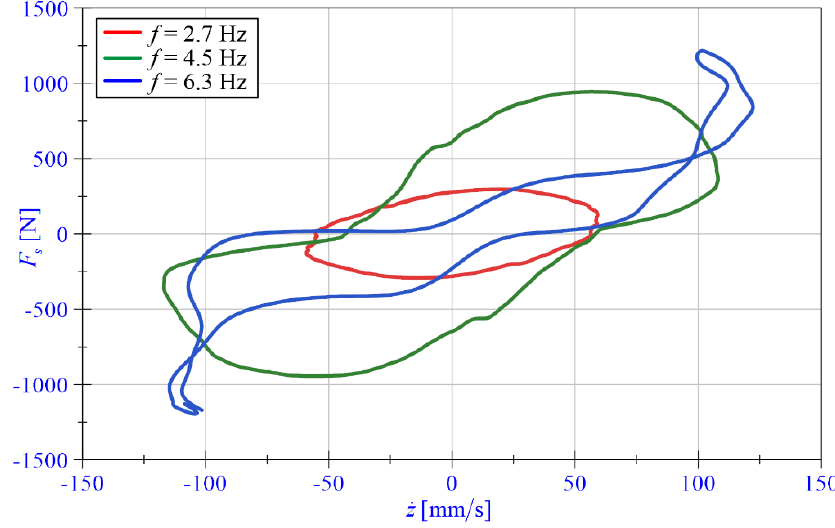
(cid:0) . (cid:1) z Case 2. Figure 5. Force-velocity loops (cid:1832) ((cid:1878)(cid:4662)) Case 2. (cid:3046)